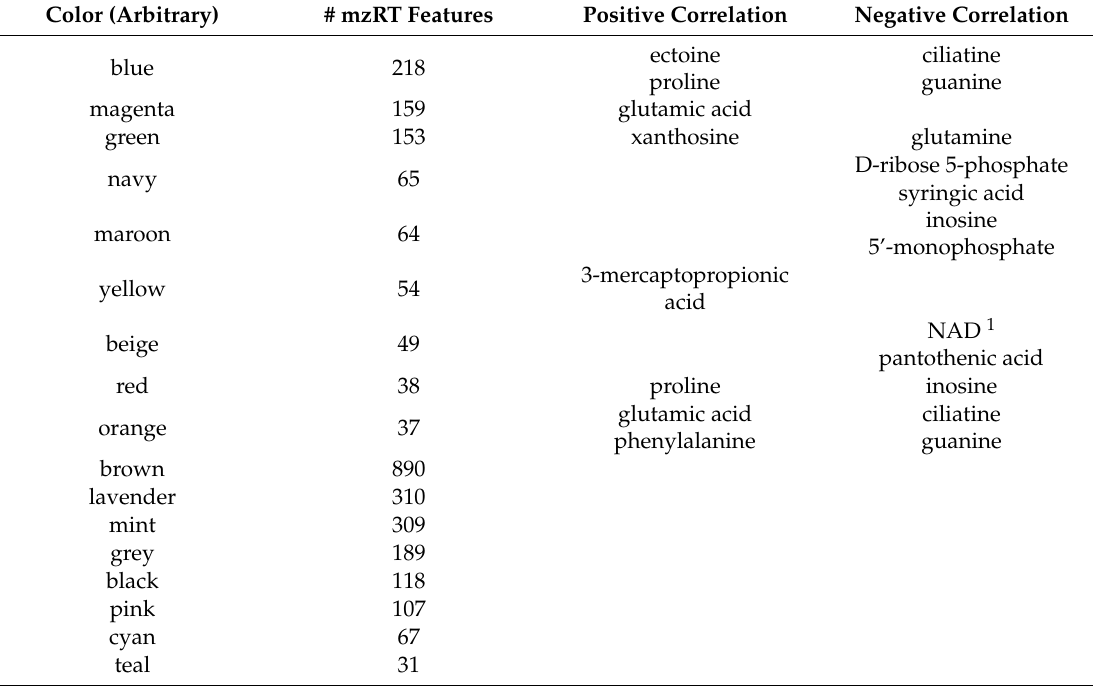
Table 3. Summary of the 17 modules defined in the untargeted metabolomics data by the WGCNA analysis. The table provides the arbitrary color names and the number of mzRT features in each module. The positive and negative correlations were calculated between the eigengene defining each color module and the targeted metabolomics